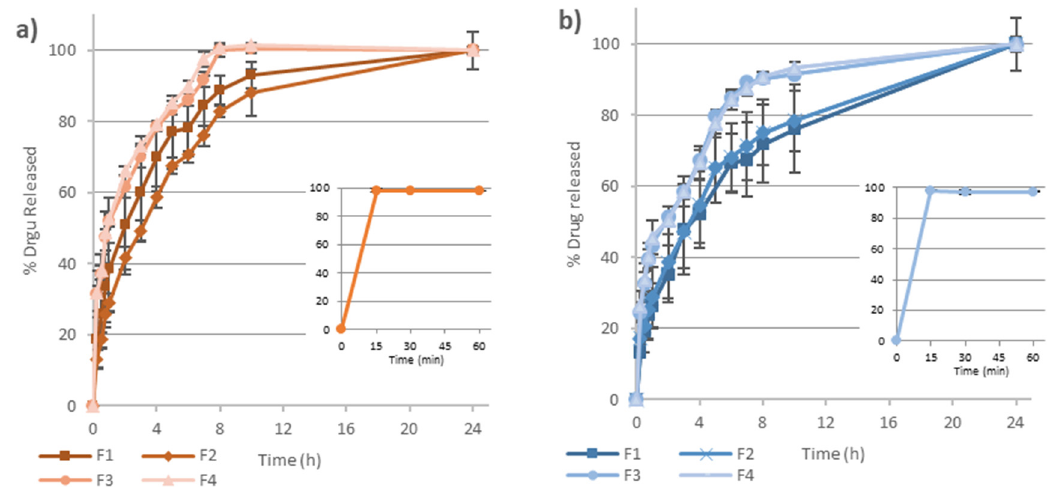
Figure 3. Accumulative percentage of dissolved metformin HCl for formulations F1–F4 matrix tablets (large graphics) and drug powder (small graphics) in ( a ) FaSSGF at pH 1.2 and ( b ) FaSSIF at pH 6.8 (n = 3).